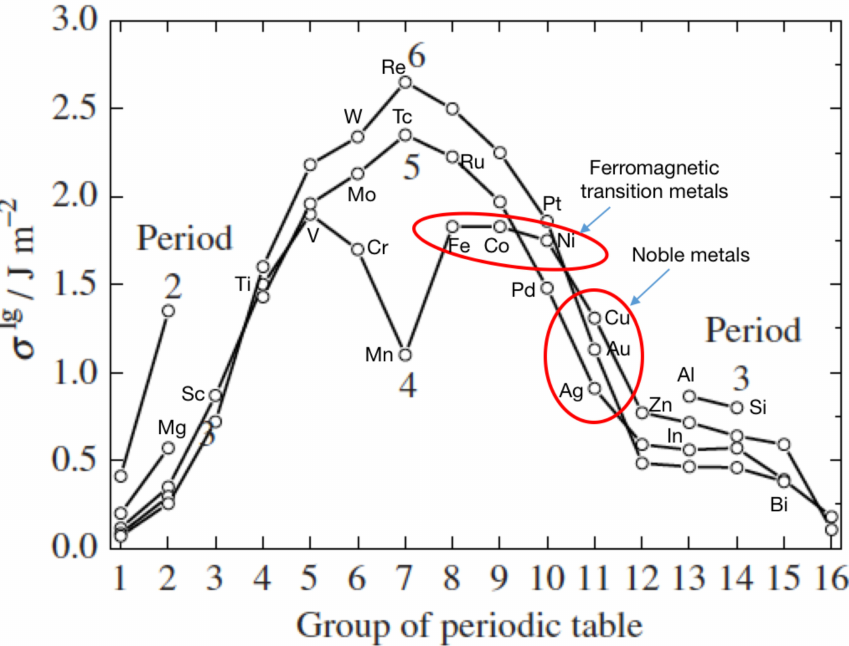
Figure 7. Value of surface tension (surface energy) of liquid metals at their melting points, with the elements appearing in Table 1 marked. Reproduced with permission from